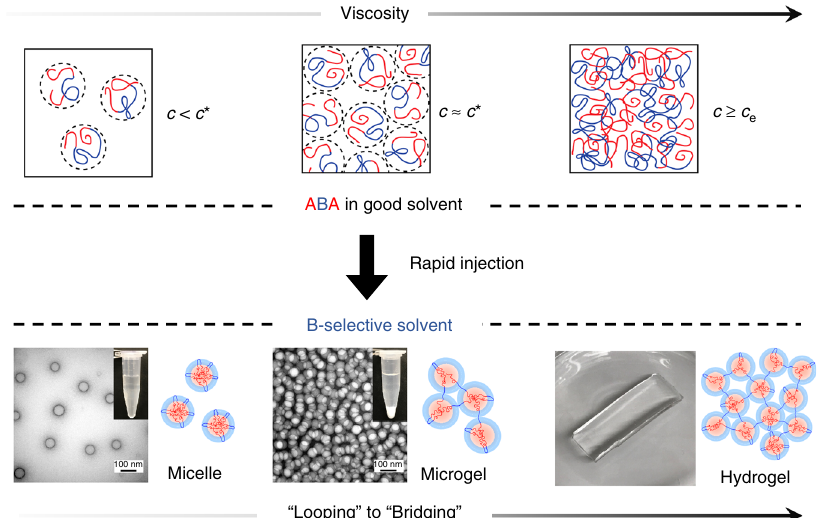
Fig. 1 Self-assembly of ABA triblock copolymers via rapid-injection. The fi nal state of the ABA triblock copolymer (micelles, microgels, and hydrogels) in a B-selective solvent is controlled and understood through the initial concentration of the polymer in the pre-injection solution. The self-assembly products ranging from micelles, microgels, and hydrogels correspond to dilute, semi-dilute, and entanglement regimes,